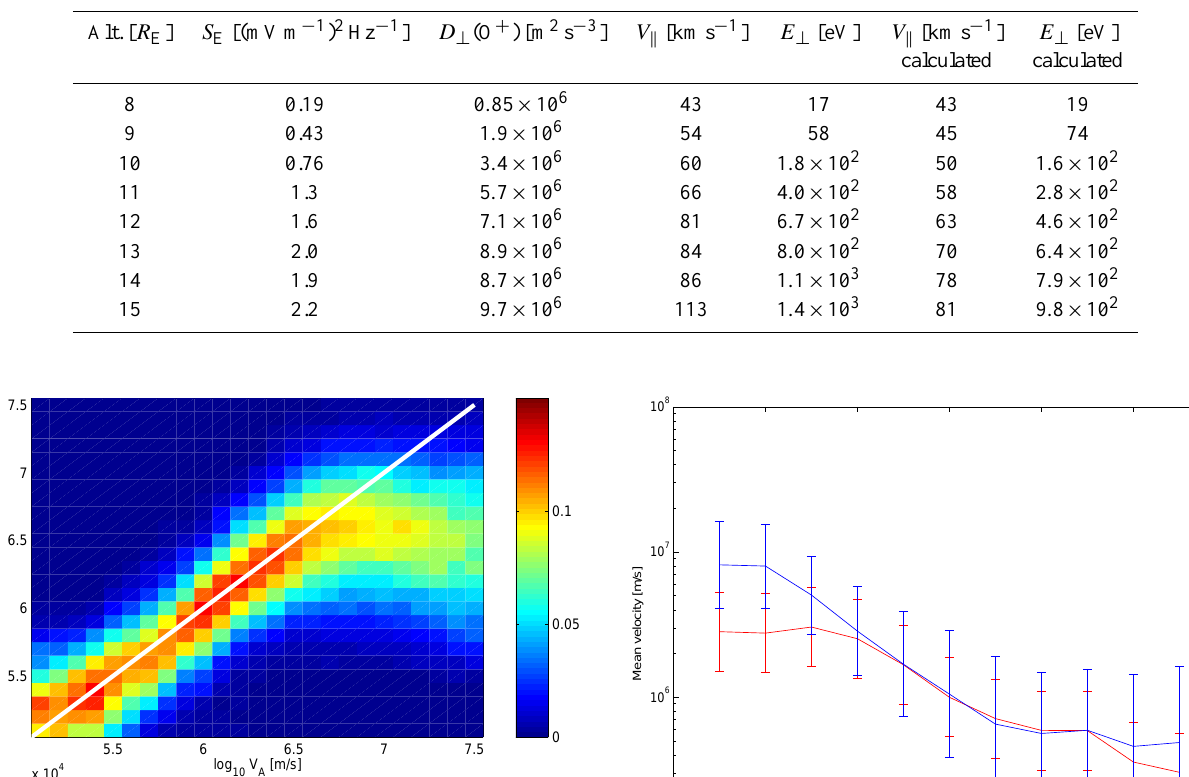
Table 1. Summary of the perpendicular diffusion coefficient for O + , the electric field spectral density at the local oxygen gyrofrequency and